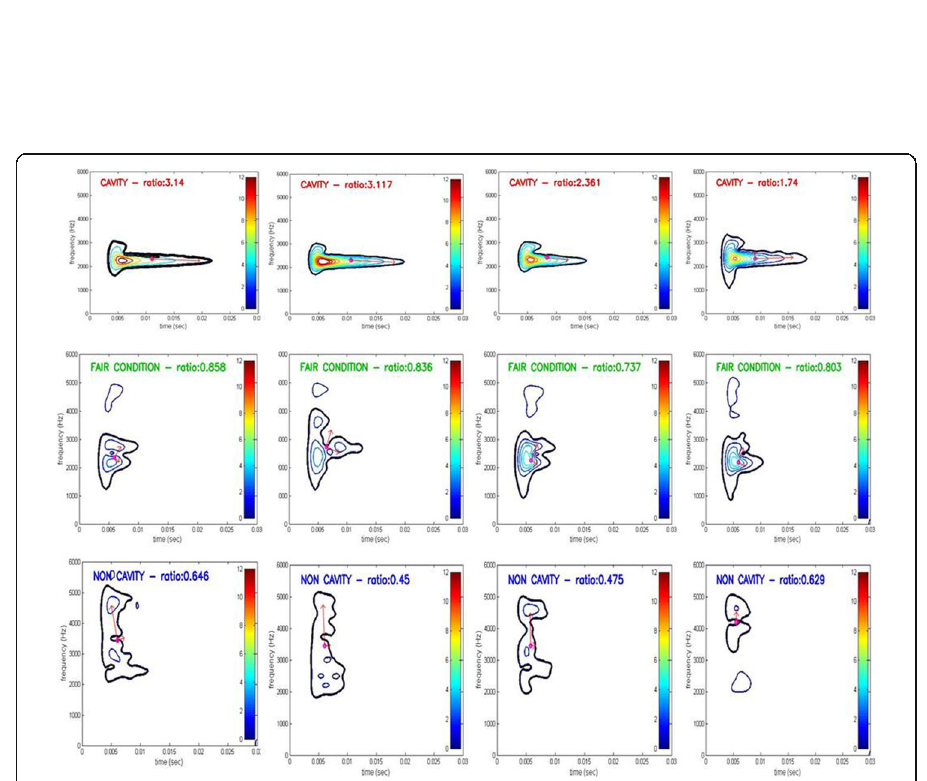
Fig. 28 Verification of cavity by using wavelet contours ratio ( Δ x/ Δ